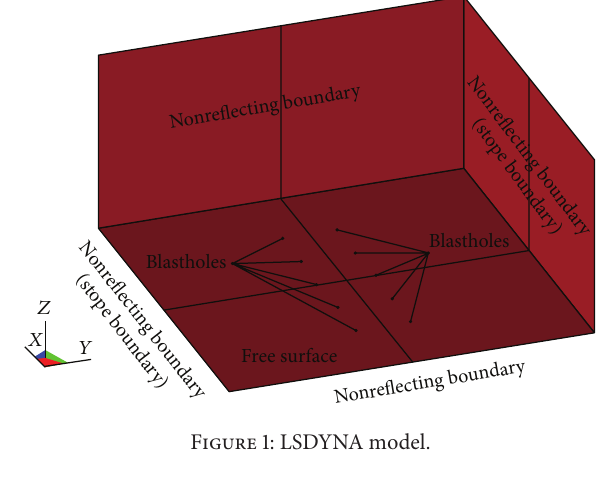
Figure 2: Numerical models with 6 m charging length.